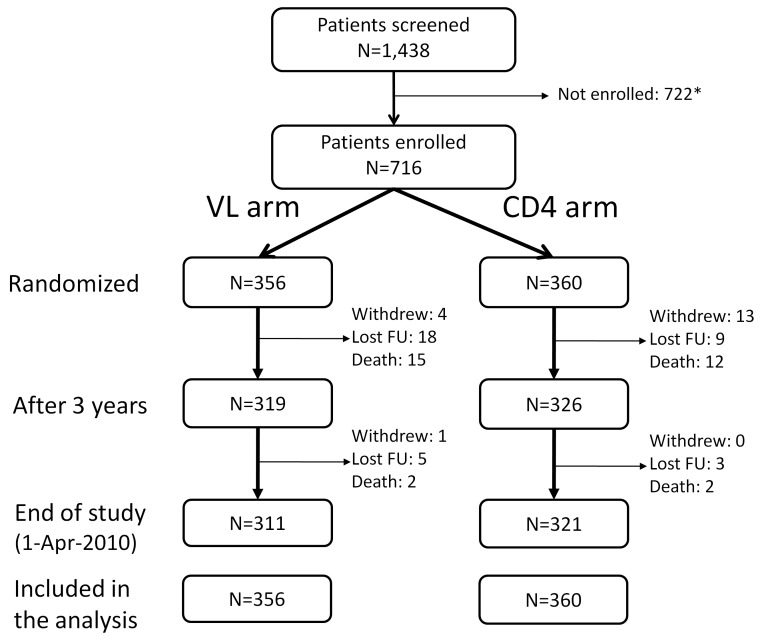
Patients' disposition.All patients randomized were included in the final analysis with patients who were lost to follow-up (FU), withdrew, or died considered as censored when last seen or at the time of death. *Reasons for not being enrolled: 158 subjects with CD4 <50 or >250 cells/mm3; 284 drop-out before enrollment (no information available for more than 2 mo); 101 with hepatitis B or C infection; 179 with other exclusion criteria such as pregnancy, opportunistic infections, or laboratory values outside the required ranges. 18 patients withdrew from the study: 11 because they moved to another region, five because they found the follow-up too frequent, and two because of side effects of the treatments.